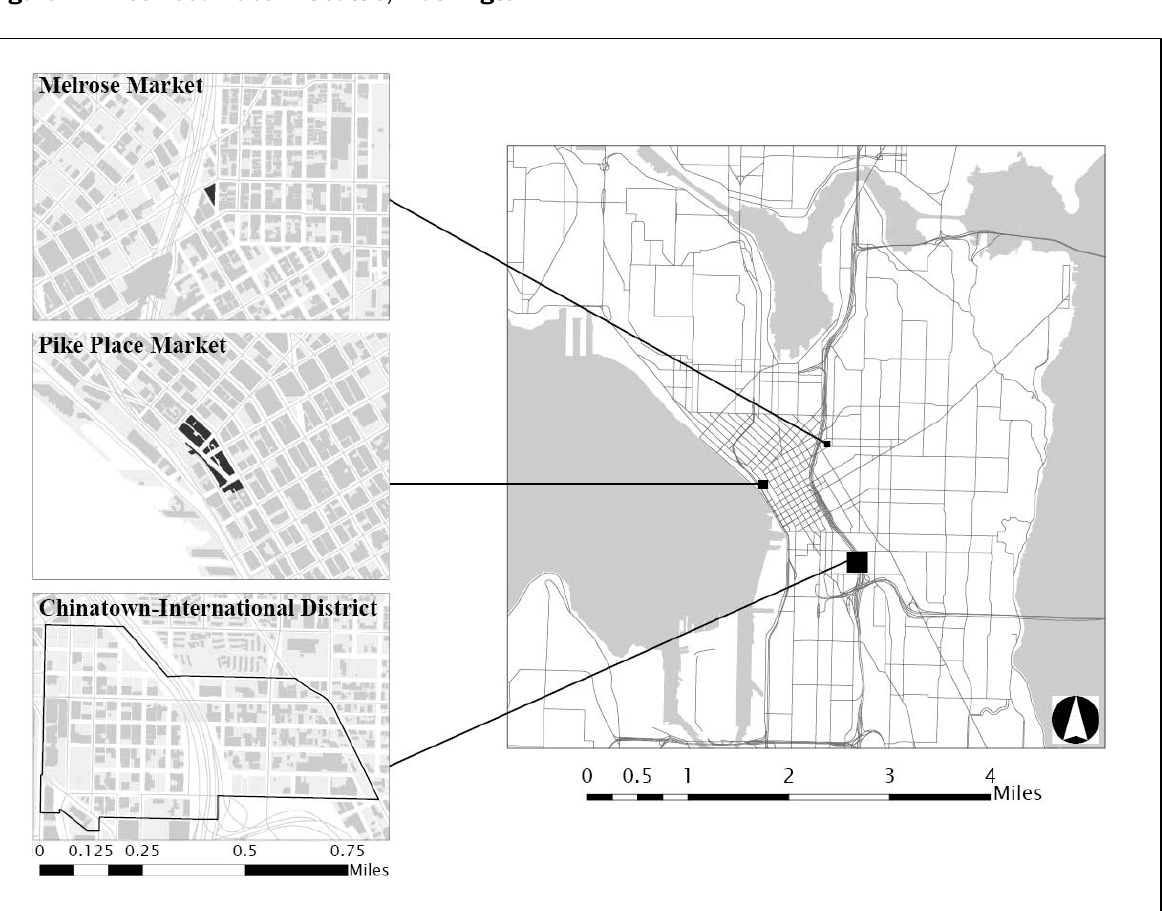
Figure 1. Three Food Hubs in Seattle,